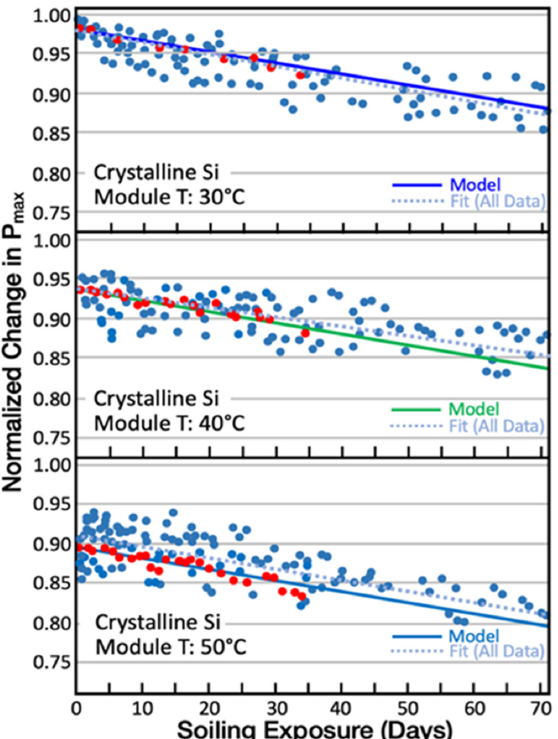
Figure 8. Normalized P max for c-Si modules at different temperatures as a function of the soiling exposure in Belo Horizonte, Brazil. The model predictions (solid lines) are included as well as a corresponding linear fit to the data (dotted lines). The red data points are for an extended single, dry period (37 days) showing better fit to the model